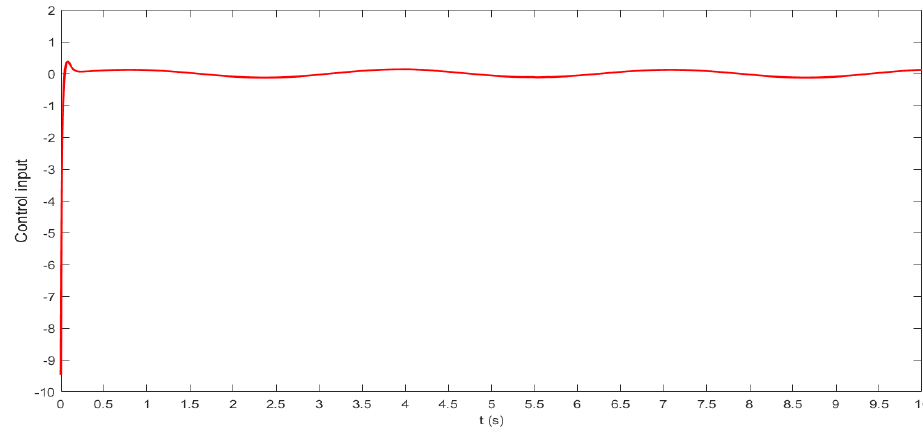
Figure 12. Control input curve.